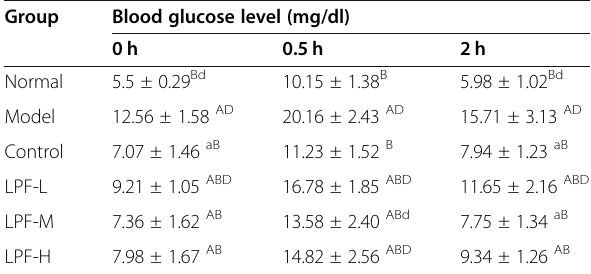
Table 5 Effect of flavonoids from L. plumule on glucose tolerance of diabetic mice